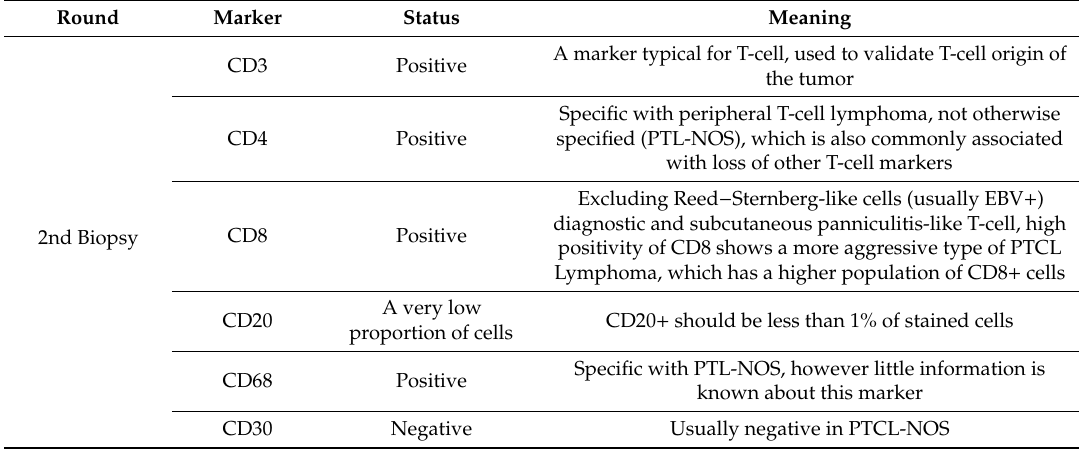
Table 1. Track-record of the pathology